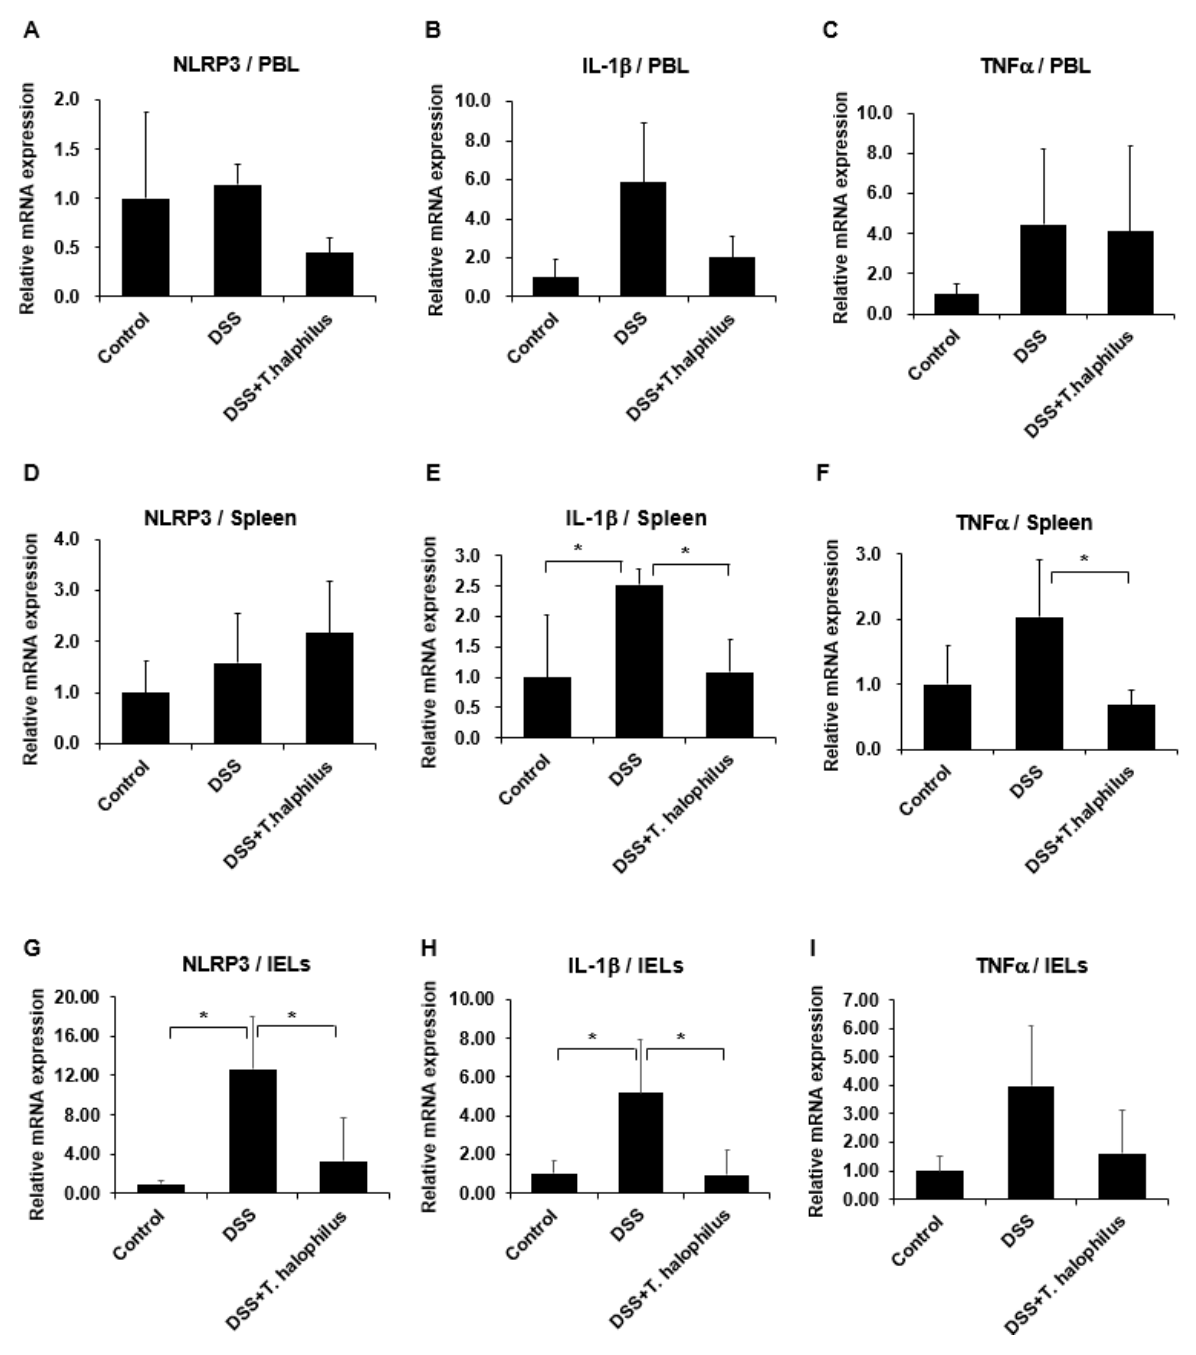
Figure 7. Effects of T. halophilus on mRNA expression levels of NLRP3, IL-1 β , and TNF α in peripheral blood leukocytes (PBL), spleens, and intestinal epithelial lymphocytes (IELs) were quantified by real-time PCR ( A – I ). Four mice were used in each experimental group. The experiment was conducted in duplicate. Significantly different p -values are indicated by an asterisk as follows: *, p < 0.05.